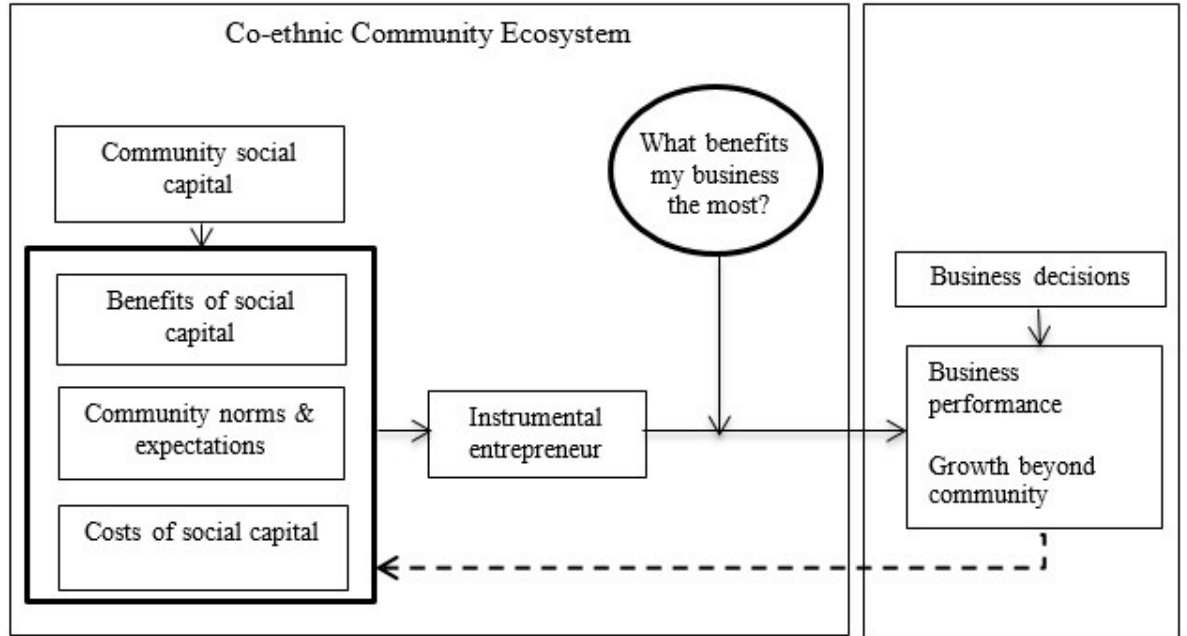
Figure 2. Instrumental Entrepreneurs—Co-ethnic social capital and its impact on